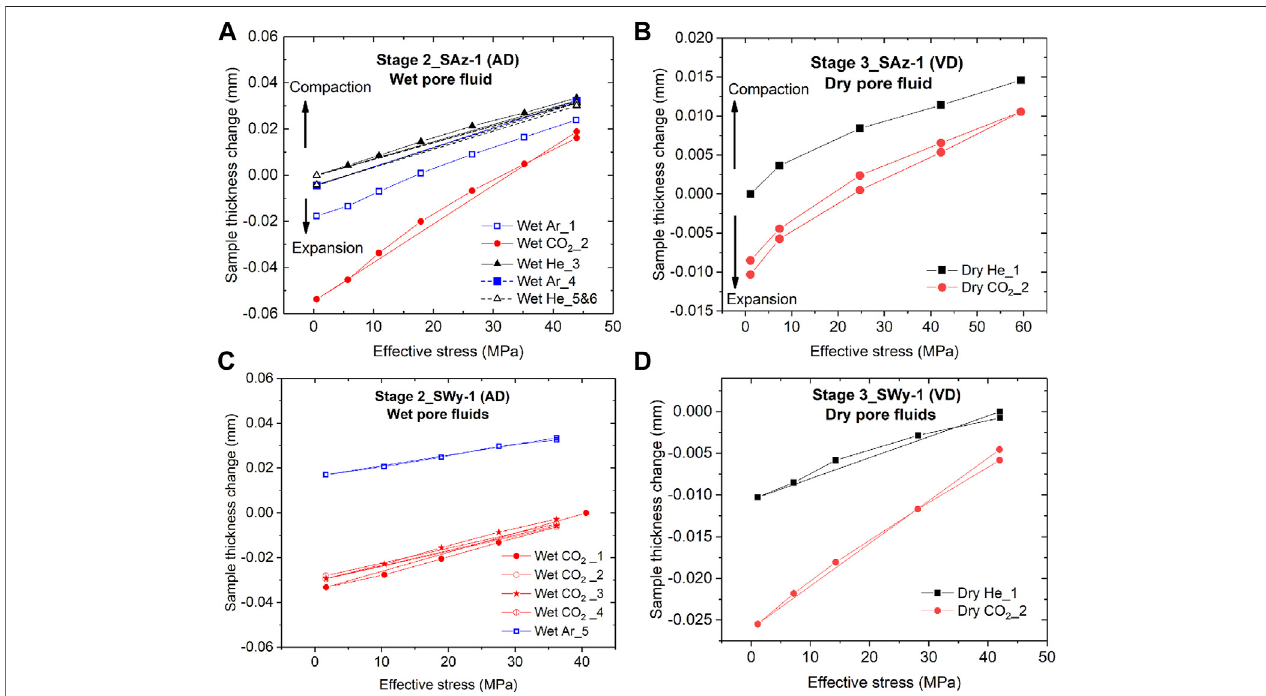
FIGURE 6 | Equilibrium sample thickness change (hence strain) versus effective stress data obtained in the Stage 2 and Stage 3 stress cycling experiments. Note that Stage 2 experiments were conducted on AD samples saturated with wet pore fl uids, while Stage 3 runs were conducted on VD samples saturated with dry